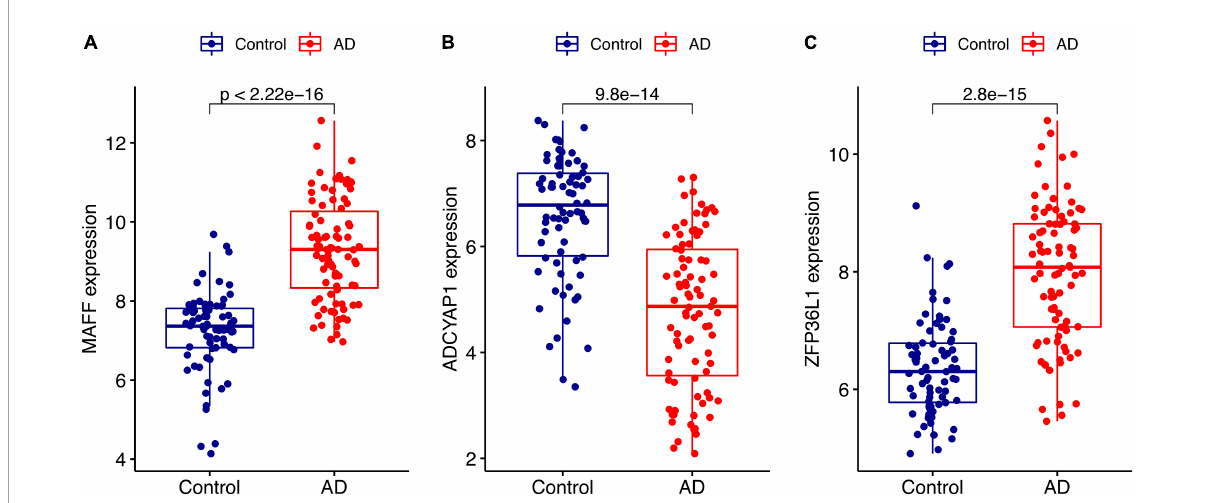
FIGURE5 Validation of the expression levels of diagnostic biomarkers in the GSE5281 dataset. (A) MAFF expression level. (B) ADCYAP1 expression level. (C) ZFP36L1 expression level.